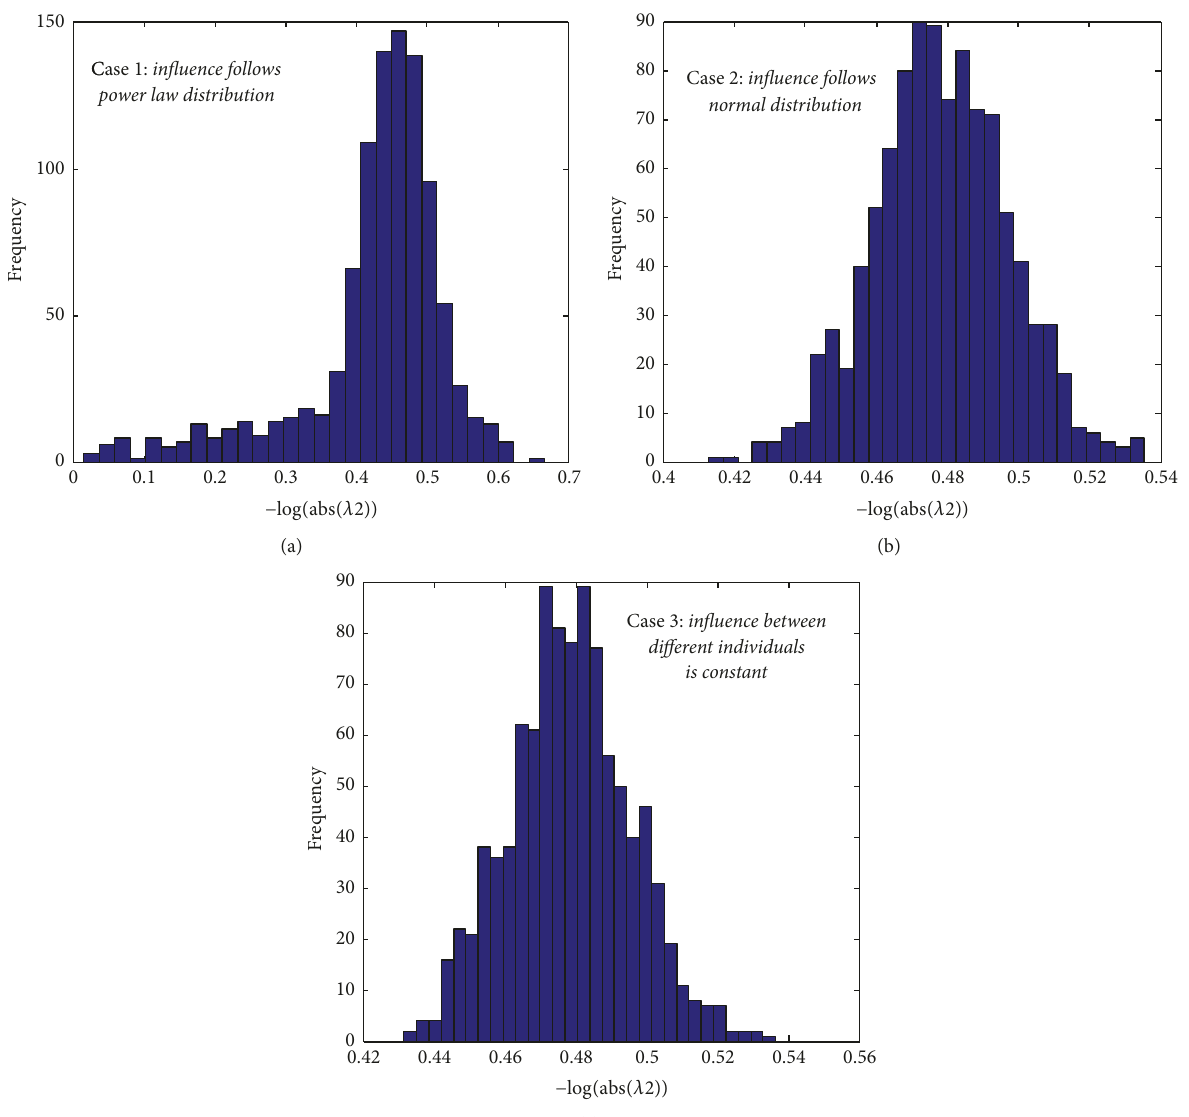
Figure 5: The distribution of convergence rate of group opinion is determined by the distribution of influence. 𝑥 -axis is the convergence rate − log (|𝜆 |) and 𝑦 -axis is the frequency (total frequency is 1000). (a) represents autocratic society; (b) and (c) represent democratic society. 2